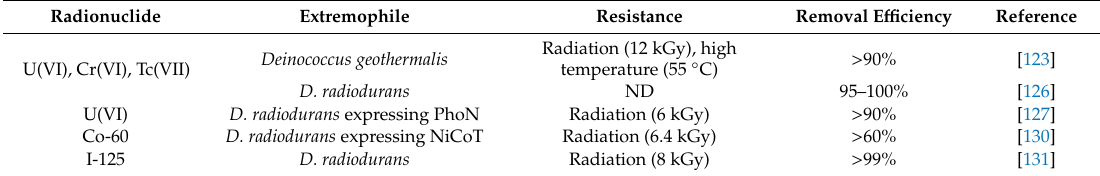
Table 3. Extremophilic microorganisms used in radioactive waste